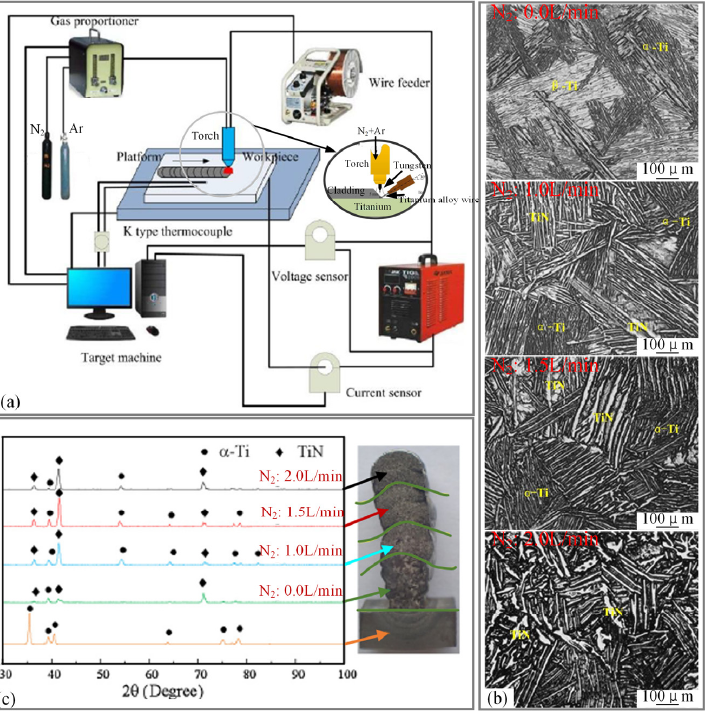
Figure 13. ( a ) Schematic of the GTA-AM system [69], ( b ) Microstructure of the cladding layer